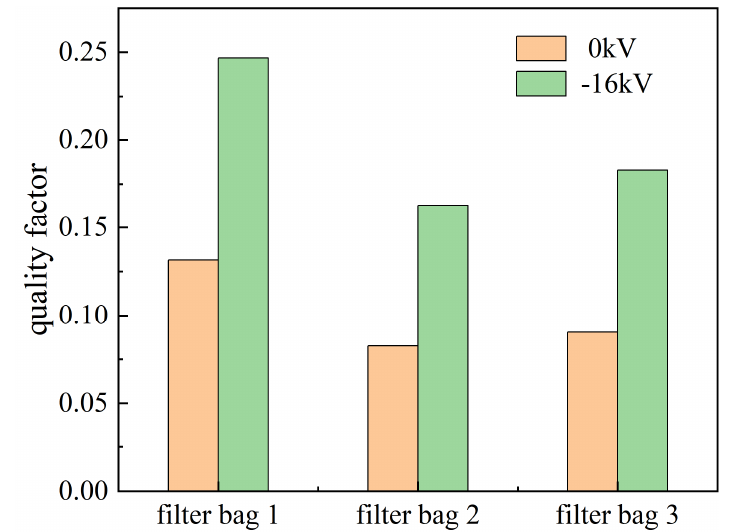
Figure 11. The quality factor of different filter bags under different experimental